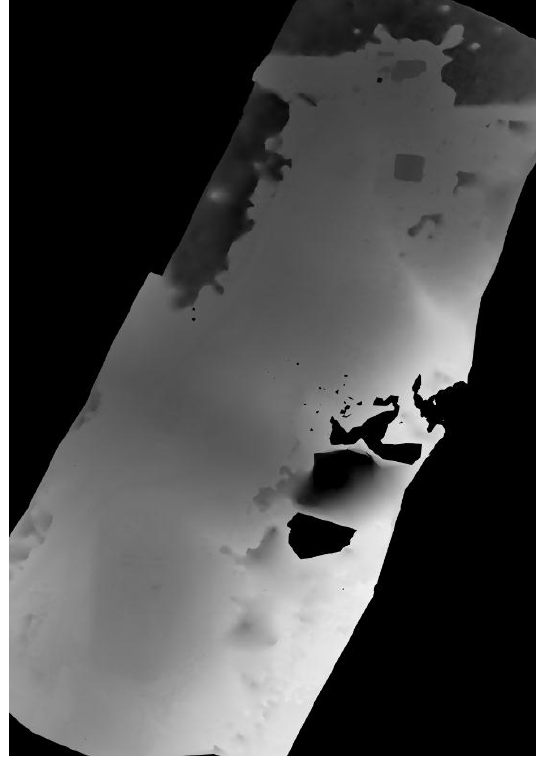
Figure 10. Digital Elevation Model made by CMP-MVS from a NGA quadcopter with a flat lens GoPro camera